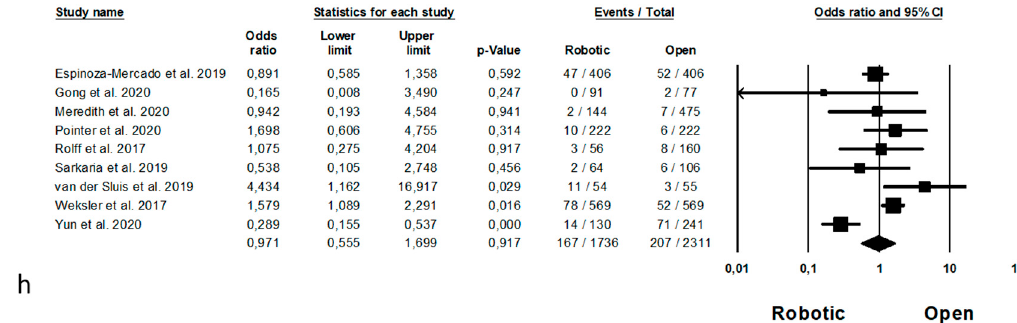
Figure 8. Robotic versus open surgery: postoperative complications. ( a ) anastomotic leakage; ( b ) postoperative bleeding; ( c ) wound infection; ( d ) pneumonia; ( e ) RLN paralysis; ( f ) chylothorax; ( g ) re-operation rate; ( h ) mortality.